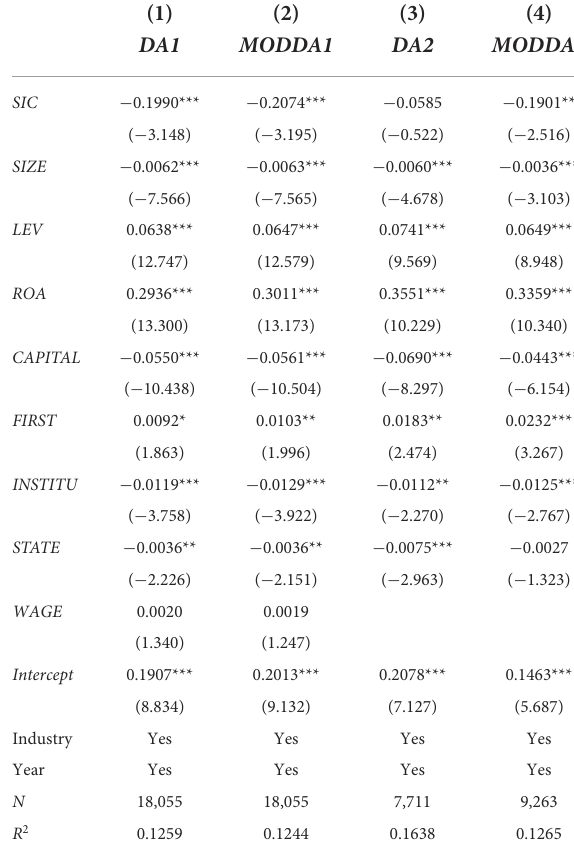
TABLE 7A Exclusion of competitive interpretation and sample replacement